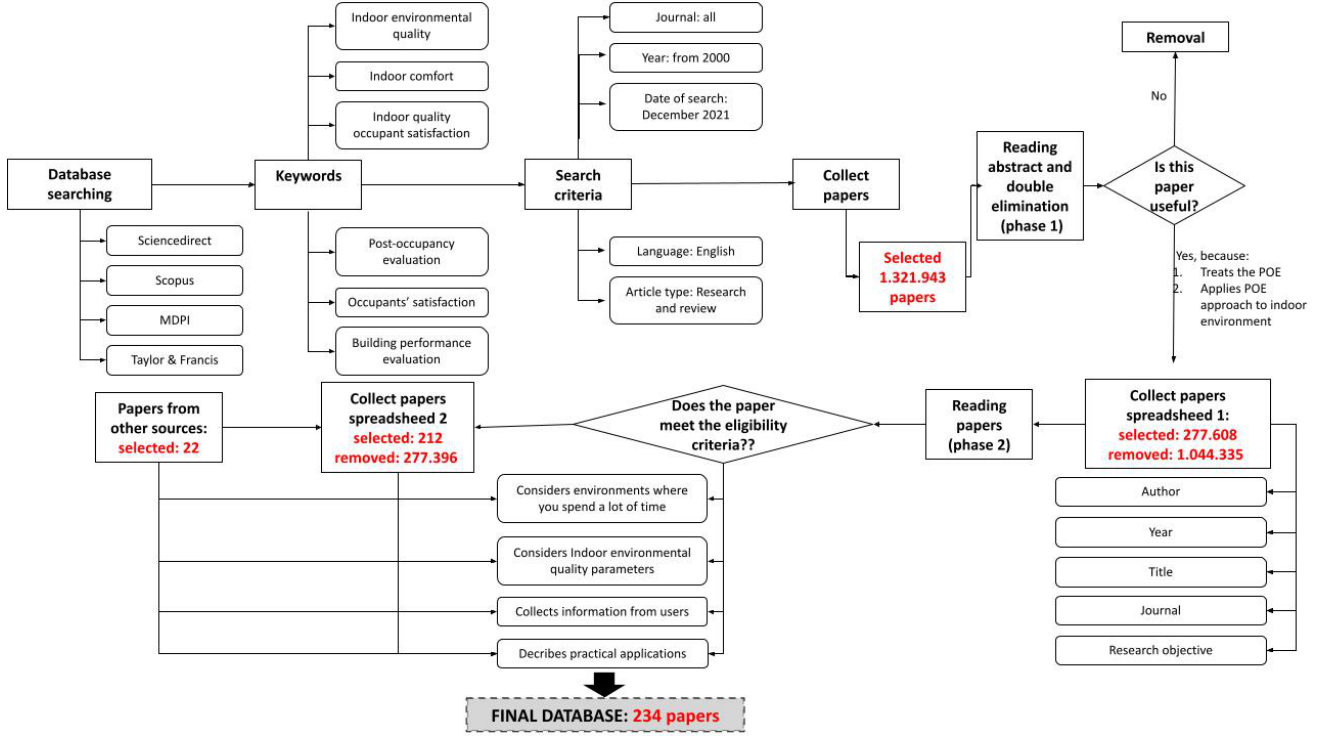
Figure 1. Research and analysis protocol.